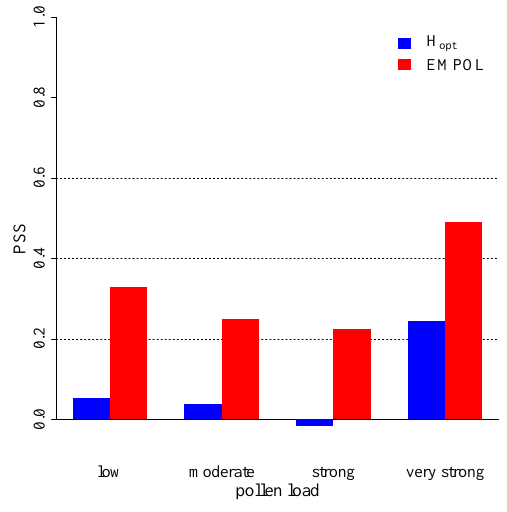
Fig. 6. Pierce Skill Score, based on classes defined by an upper and lower